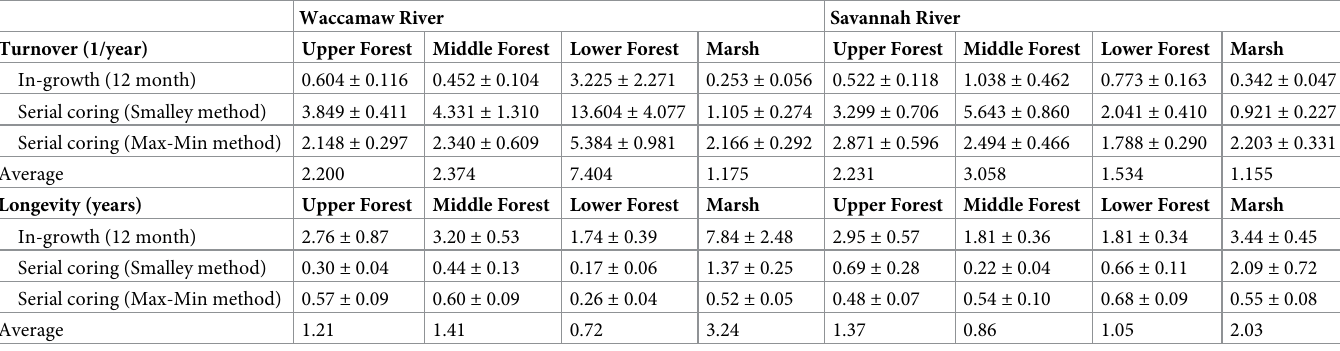
Table 4. Average root turnover (1/year) and longevity (years) to a depth of 30-cm for TFFW and marshes by